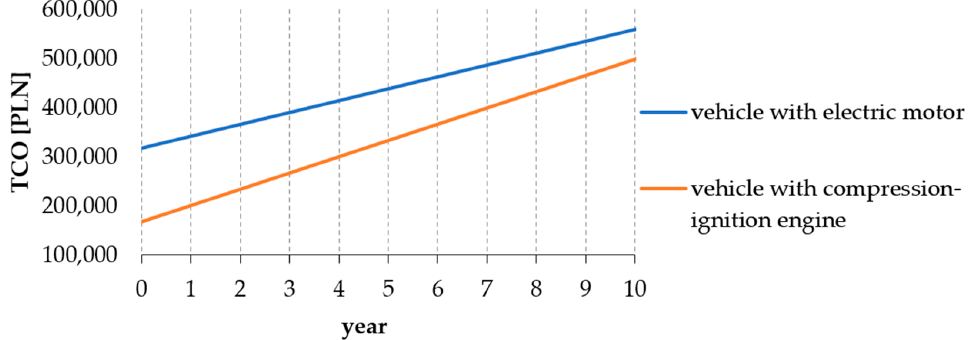
Figure 18. Total cost of ownership of vehicle during the whole operating period—electric vehicle is recharged only at public AC charging stations (the highest price for 1 kWh was included in the calculations—Scenario A3).